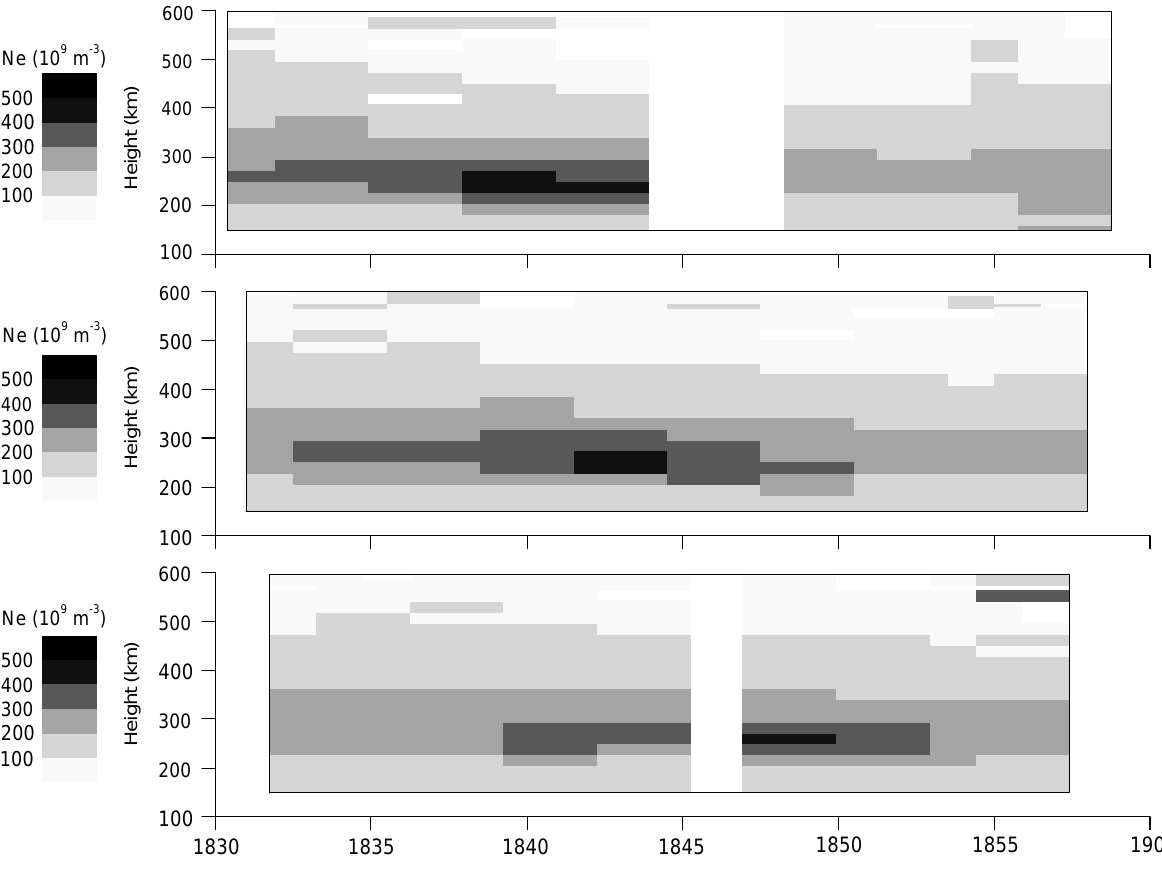
(north), 90 ° and 84 ° (south). An F -region feature is seen first in the top panel at 1838 UT. It then moves southwards through the other two positions, finally disappearing at around 1850 UT